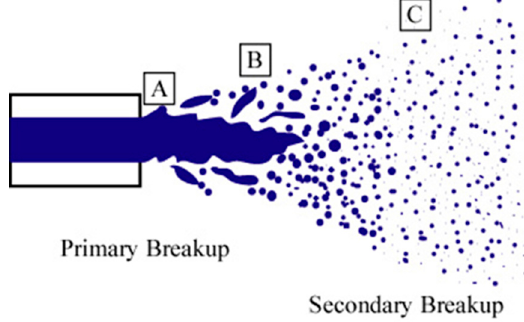
Figure 2. Schematic of a turbulent liquid fuel spray.